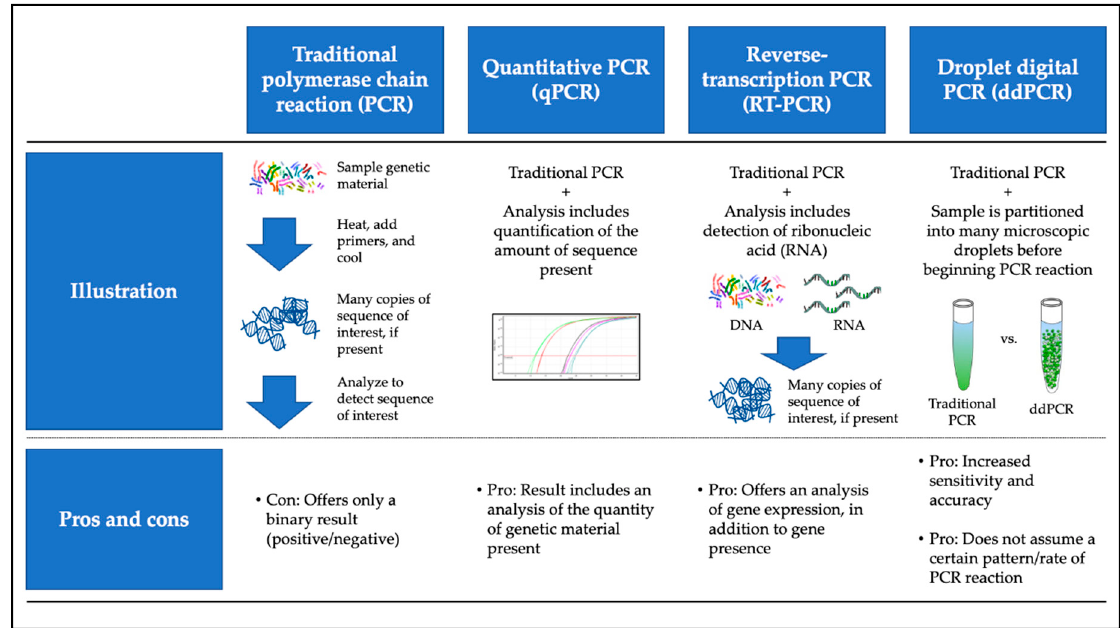
Figure 1. Overview of most commonly used molecular techniques for non-invasive HPV biomarker testing. Includes color images available from Wikimedia as part of the creative commons